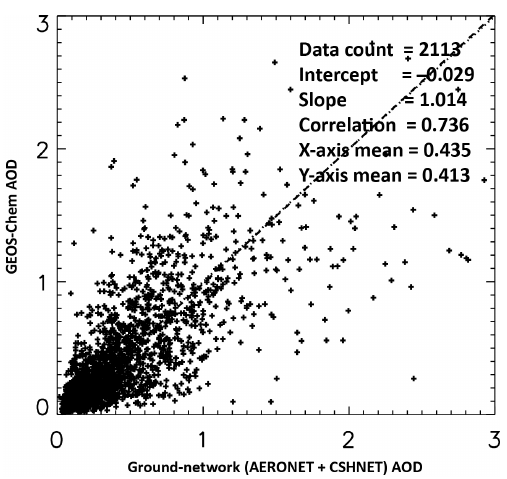
Figure A2. Scatterplot of AOD at 550nm from GEOS-Chem simu- lations vs. ground networks (AERONET + CSHNET). Model AOD has been adjusted by MODIS AOD on a monthly basis (see Ap- pendix